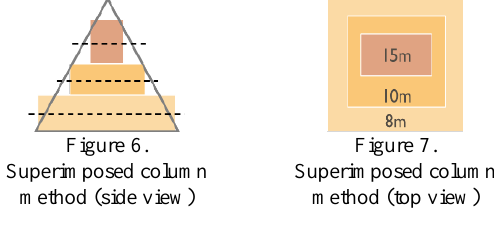
Figure 10. LiDAR point cloud of NTU